Question: Express in one sentence what the figure is showing.
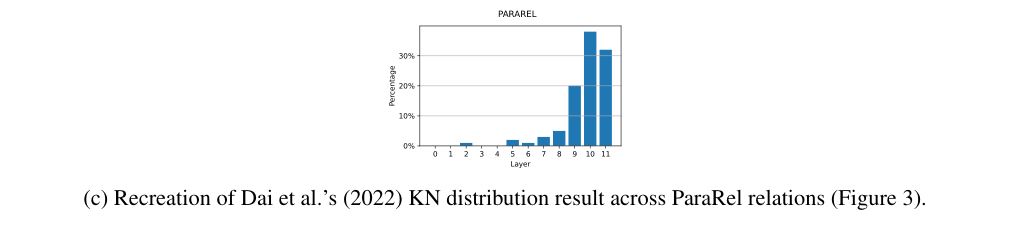
Answer: Percentage of knowledge neurons identified in different BLiMP paradigms using BERT.